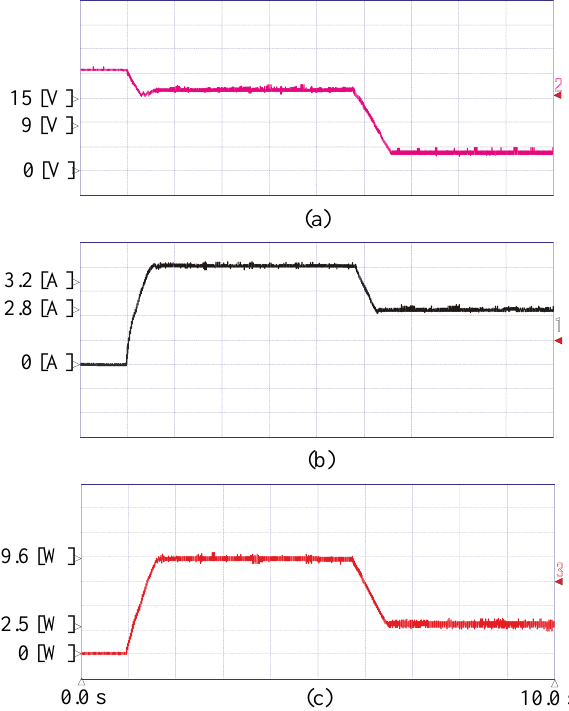
Figure 21. Experimental results of P&O MPPT considering Case 3. ( a ) PV voltage, ( b ) PV current, and ( c ) PV